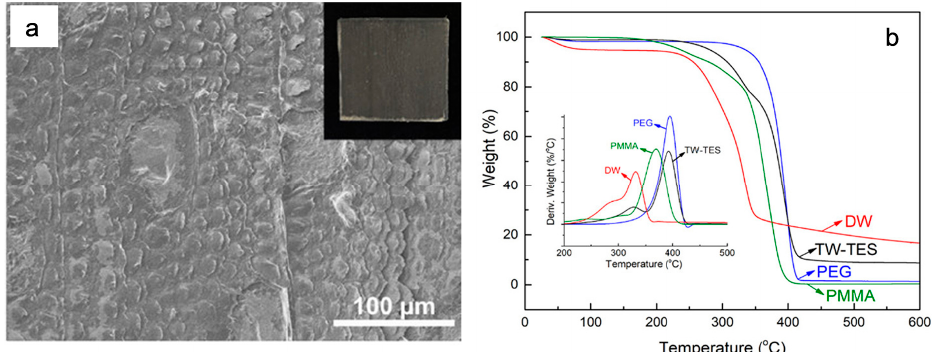
Figure 5. ( a ) SEM micrometre graph showing the successful impregnation of DW with PEG/PMMA; ( b ) the thermogravimetric analysis and differential thermogravimetric analysis curves of DW, neat PEG, neat PMMA and TW-TES composite. Abbreviations are: DW = delignified wood, PMMA = polymethyl methacrylate, and TW-TES = transparent wood for thermal energy storage. Adopted from reference [28], copyright 2019, American Chemical Society.